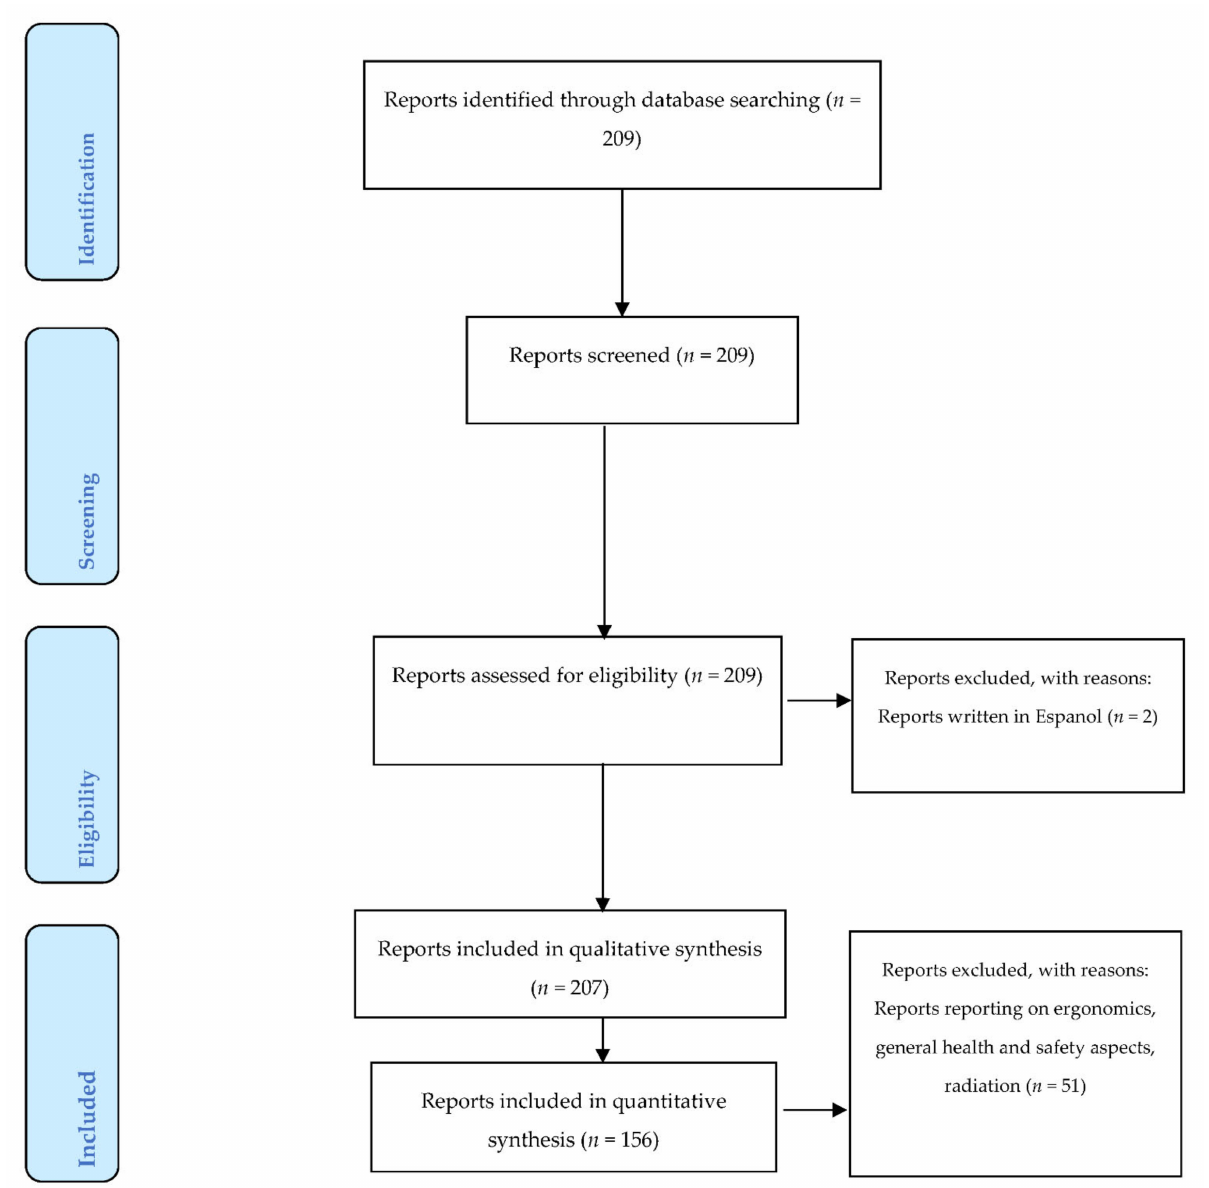
Figure 2. PRISMA flow